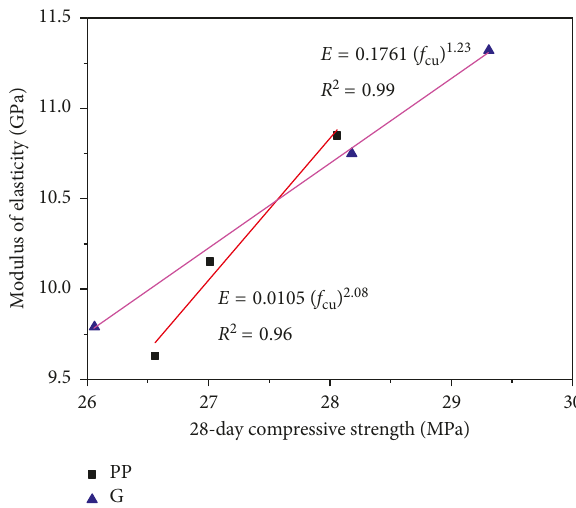
Figure 13: Percentage value of water absorption and open porosity of